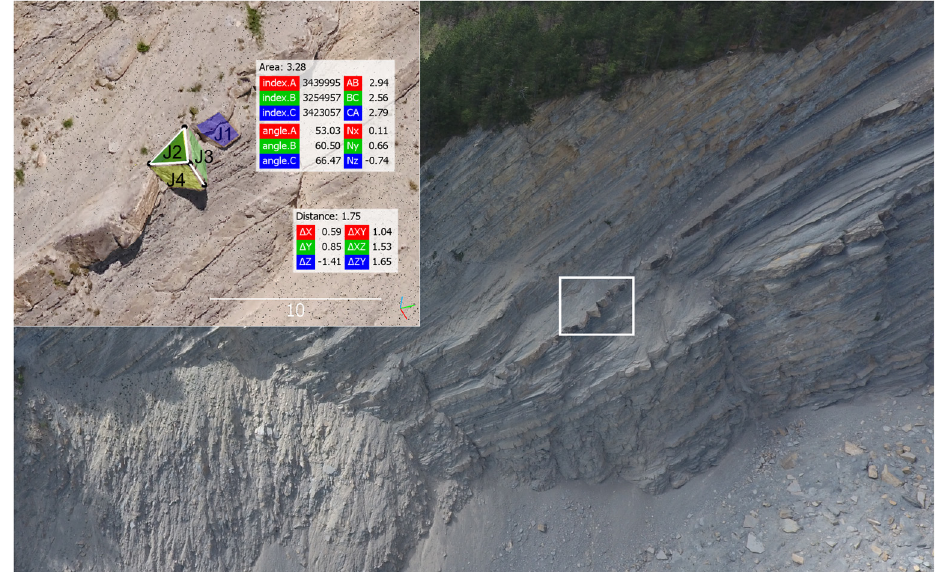
Figure 15. Overview of the left part of the Poggio Baldi landslide rock scarp and details of typical in situ rock block dimensions measured from the point cloud (white box).